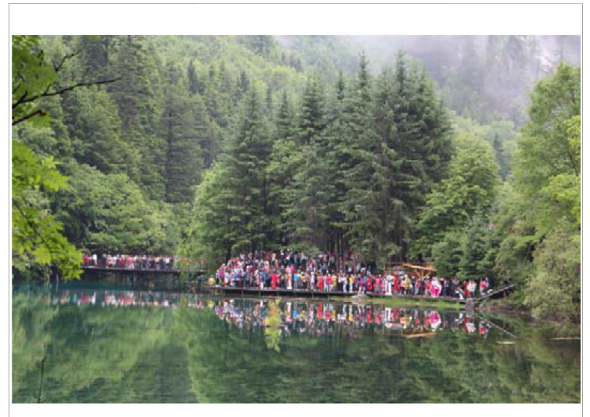
FIGURE 6 Visitors gathered at the Mirror Sea scenic spot despite the in fl uence of COVID-19 (the photograph was taken in June